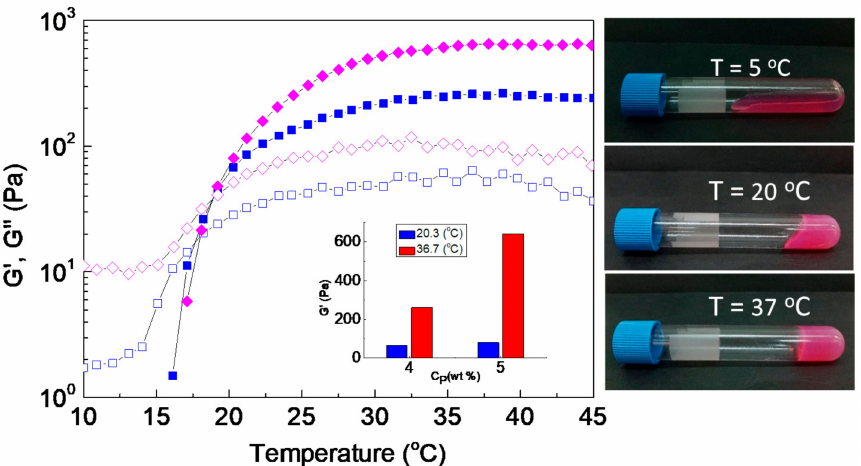
Figure 9. Temperature dependence of G’ (closed), G” (open) (at 1 Hz, γ = 0.1%, heating rate 1 ◦ C/min) for NaALG- g -P(NIPAM 80 - co -NtBAM 20 ) graft copolymer in Dulbecco’s modified Eagle’s medium (DMEM) at 5 wt % (diamonds) and 4 wt % (squares) polymer concentration. The inset demonstrates the storage modulus, G’ , at room and body temperatures. The photos ( right ) illustrate the solutions of 4 wt %, equilibrated at the indicated